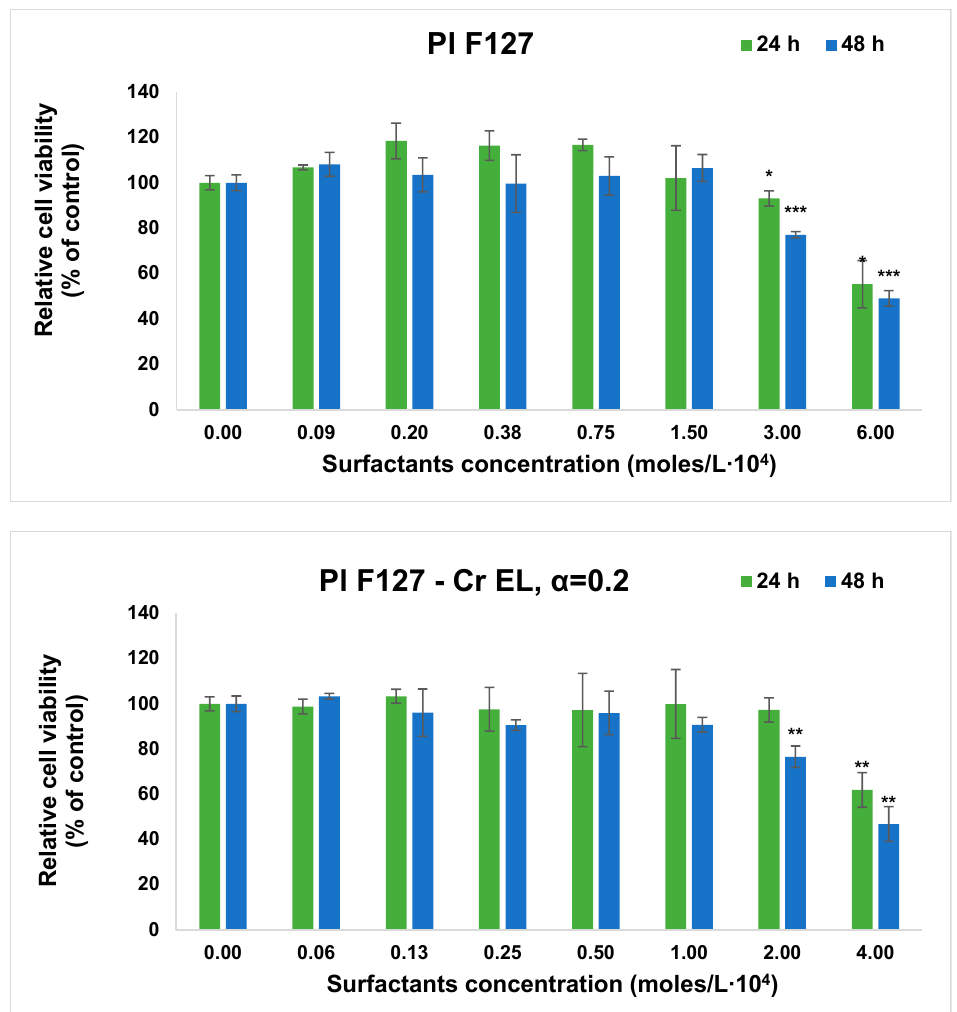
Figure 6. Cell viability results obtained by MTT assay after 24 and 48 h of cell growth in the presence of surfactants. Results are presented as mean ± standard deviation of three independent experiments (* p < 0.05, ** p < 0.01 and *** p < 0.001 compared with control).